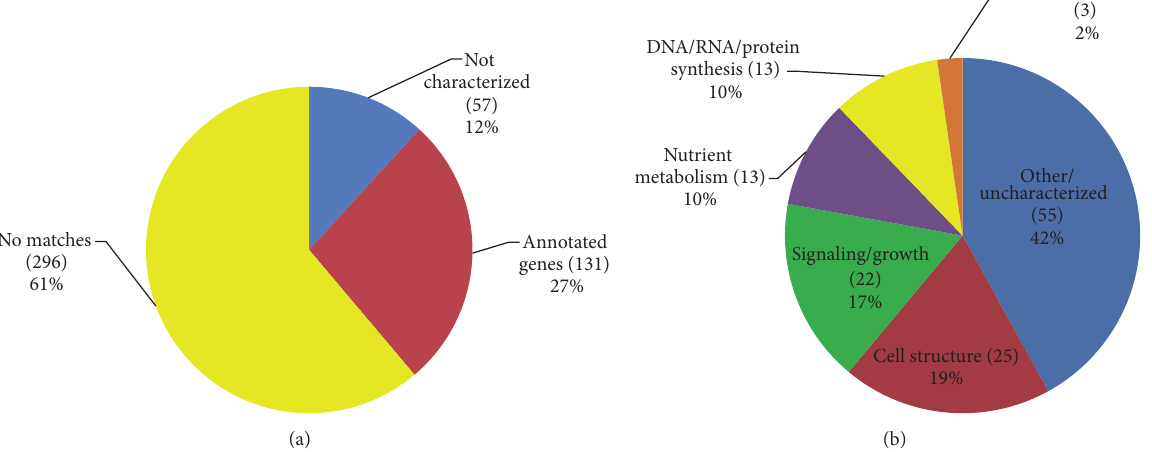
Figure 2: Categorization of differentially expressed genes from FG Mya arenaria. (a) Summary of identification of top 484 differentially expressed genes. (b) Summary of categories of Gene Ontology (GO) for the genes from (a) that were successfully annotated. List of 131 different genes identified were annotated with Gene Ontology biological process